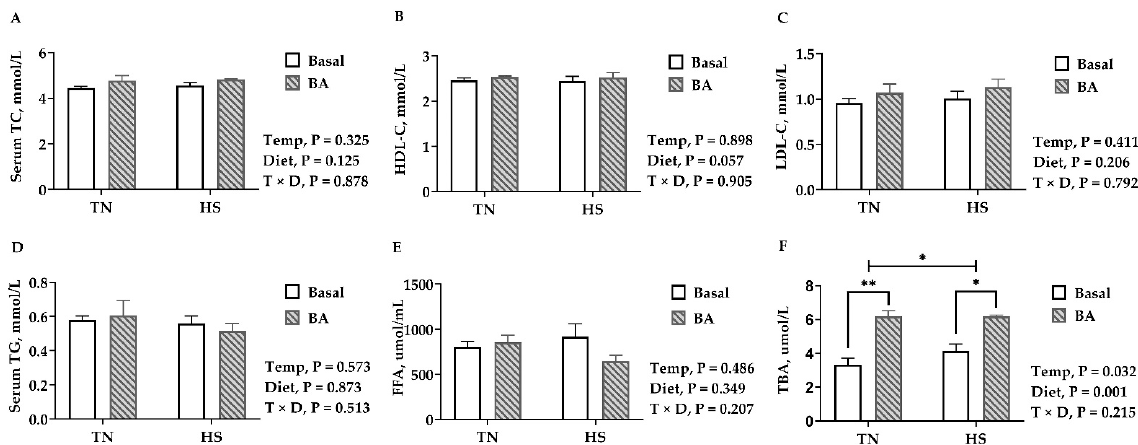
Figure 4. Lipid profiles in the serum of broilers fed with 0 or 200 mg/kg bile acids under thermoneutral (TN) and heat- stressed (HS) conditions. ( A ) TC, total cholesterol; ( B ) HDL-C, high-density lipoprotein cholesterol; ( C ) LDL-C, low-density lipoprotein cholesterol; ( D ) TG, triglycerides; ( E ) FFA, free fatty acid; ( F ) TBA, total bile acid. Data are the means ± SEM (n = 6 for each group). * p < 0.05 and ** p <